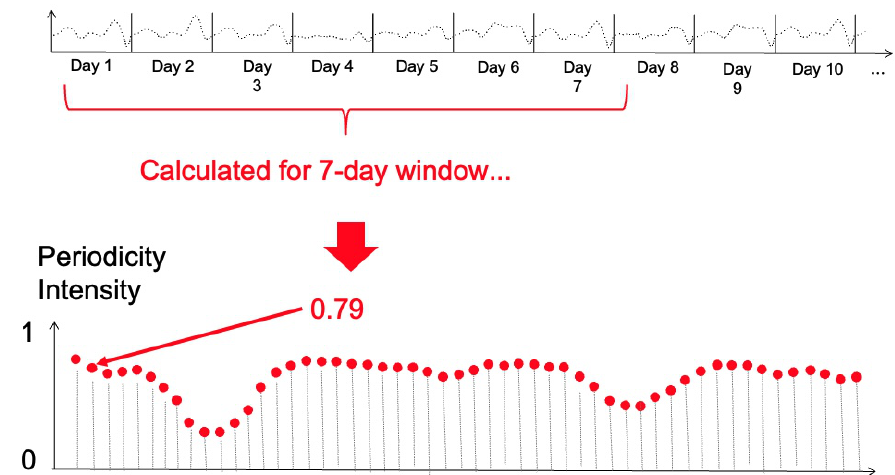
Figure 2. Schematic for the calculation of periodicity intensity for a calf. Figure shows 10 days of SVM values (top part of the figure) with a 24 h periodicity intensity for a 7-day window calculated starting just after the start of recorded data and yielding a value of 0.79. This sliding window will shift forwards in time and to the right on the schematic graph by 15 min and re-calculate the 24 h periodicity intensity. This is repeated until the end of the data recording gives the time series plotted on the bottom half of the Figure, with periodicity intensity values calculated at 15 min